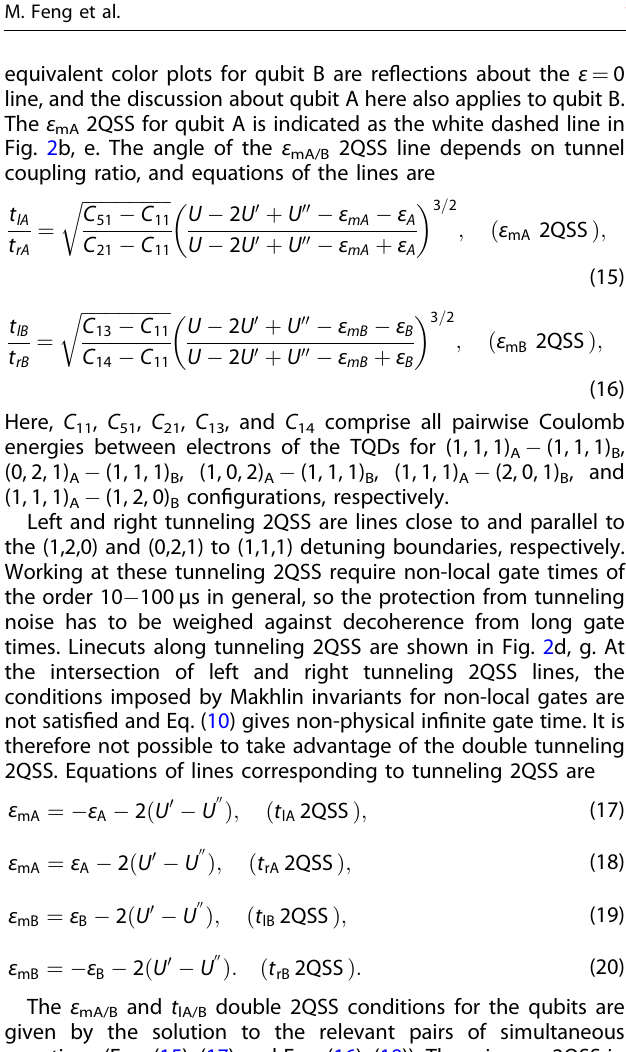
Numerical simulations of Eq. (13) with noisy parameters are averaged to give in fi delity 1 (cid:3) Fh i , and compared with that from i . Results are plotted in Fig. 3 for noise affecting the non-local gate for qubit A only. The reason is that results for noisy qubit B or both qubits noisy are qualitatively similar and the ´ analytic fi delity acquires a simple expression, hF an i ¼ hF an i A (see Supplementary Discussion 2). hF an i B In fi delity results are shown in Fig. 3, which we refer to in the rest of this section. Numerical simulations are calculated by averaging over 500 noise realizations for every point in detuning space, except at double t l and ε m 2QSS which are averaged over 100 realizations. The reason is the much longer gate times (up to ~100 μ s) at those points result in impractical runtimes. In fi delities from numerical simulations are shown in the leftmost column (Fig. 3a, e, i, m, q, u), analytical in fi delity (Eq. (14)) in the second column (Fig. 3b, f, j, n, r, v). Each pair of in fi delity color plots have the same scale to facilitate comparison. Horizontal linecuts (circles) from numerical in fi delity results are plotted with analytical in fi delity (lines) in the third column (Fig. 3c, g, k, o, s, w). Similarly, vertical linecuts (squares) are plotted in the rightmost column (Fig. 3d, h, l, p, t, x). Color scales for linecuts indicate the standard deviation of the noisy parameter at which the linecut was taken. All plots display good agreement